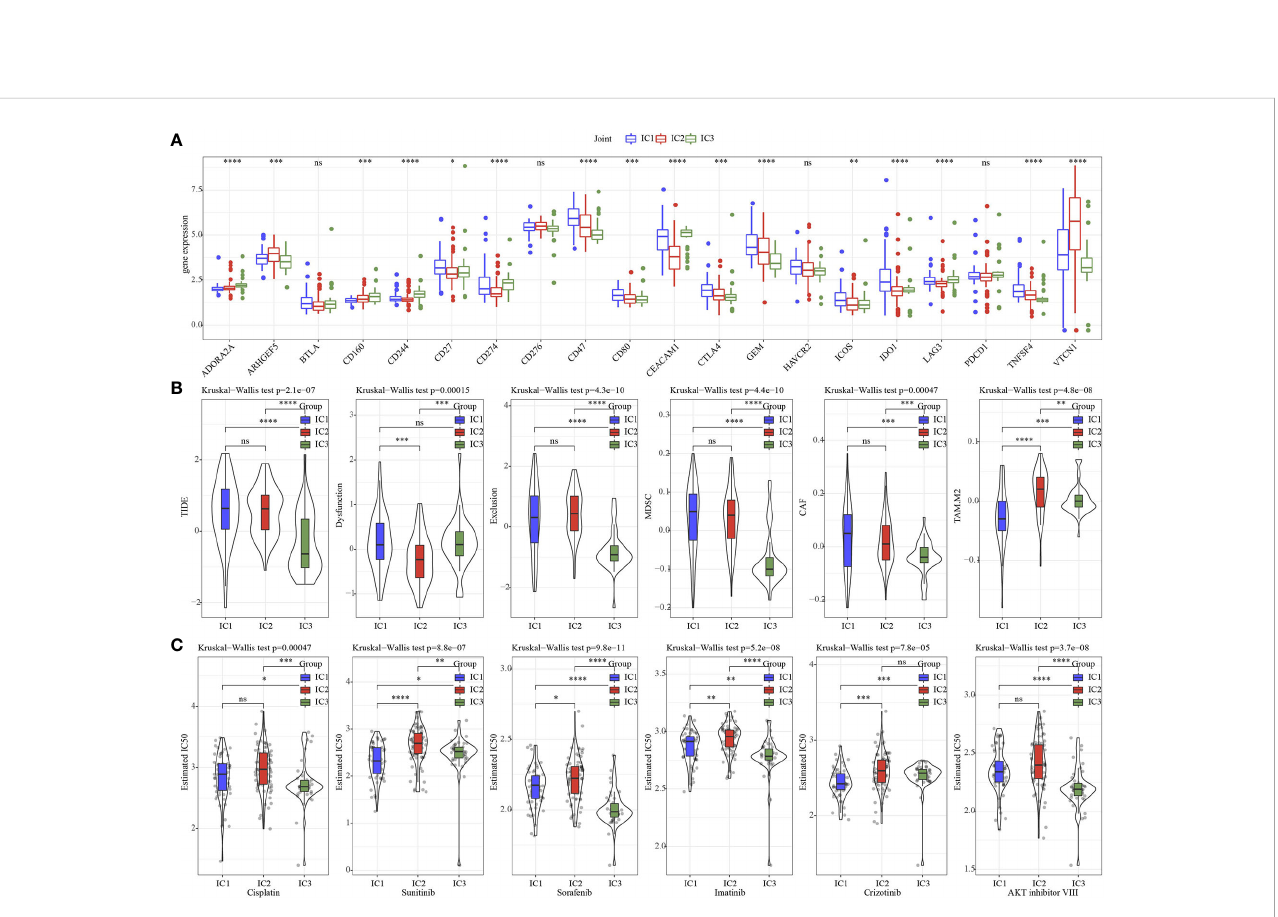
FIGURE 5 Immunotherapy analysis. (A) The expression levels of 20 immune checkpoint genes in 3 molecular subtypes. (B) TIDE analysis in 3 molecular subtypes. (C) The box plots of the estimated IC50 for Cisplatin, Sunitinib, Sorafenib, Imatinib, Crizotinib and AKT inhibitor VIII in 3 molecular subtypes. * p<0.05, ** p<0.01, *** p<0.001, **** p<0.0001, ns, no